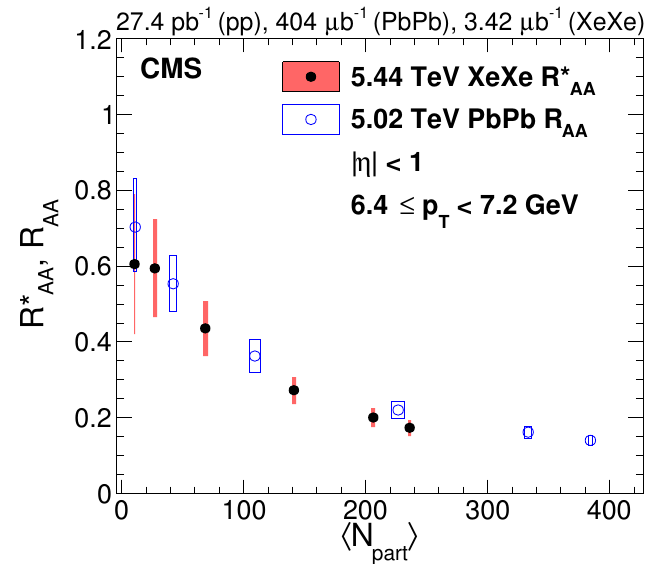
p for XeXe collisions at s = 5 : 44 TeV and R AA for PbPb AA NN